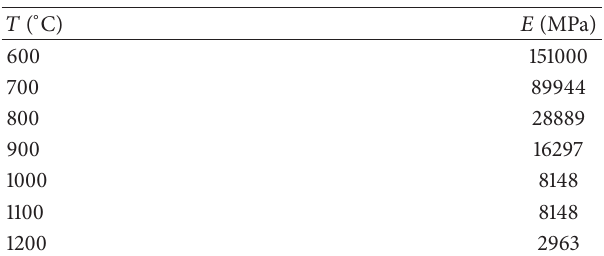
Table 1: Values of Young’s